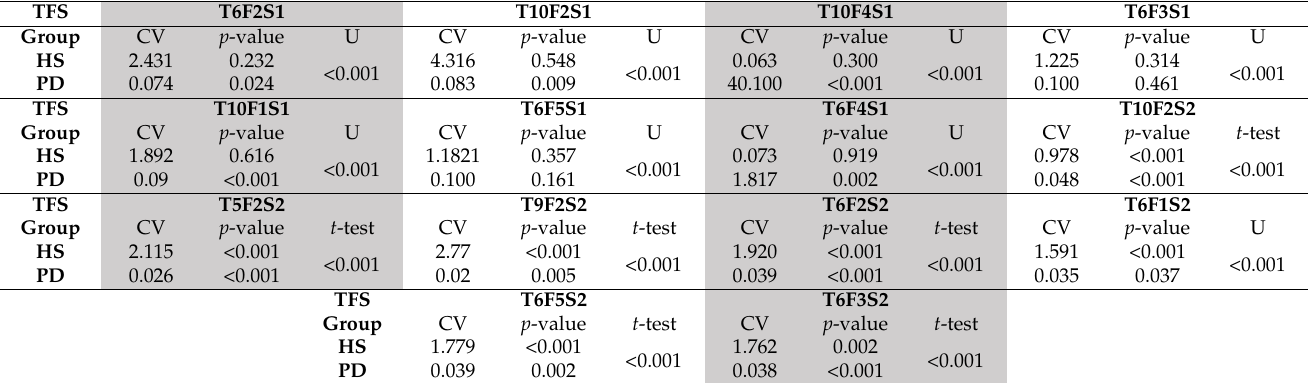
Table 4. Results of coefficient of variation for the two groups, with the p -value of the Shapiro-Wilk test and the p -value for the statistical test ( t -test or Mann-Whitney U test).